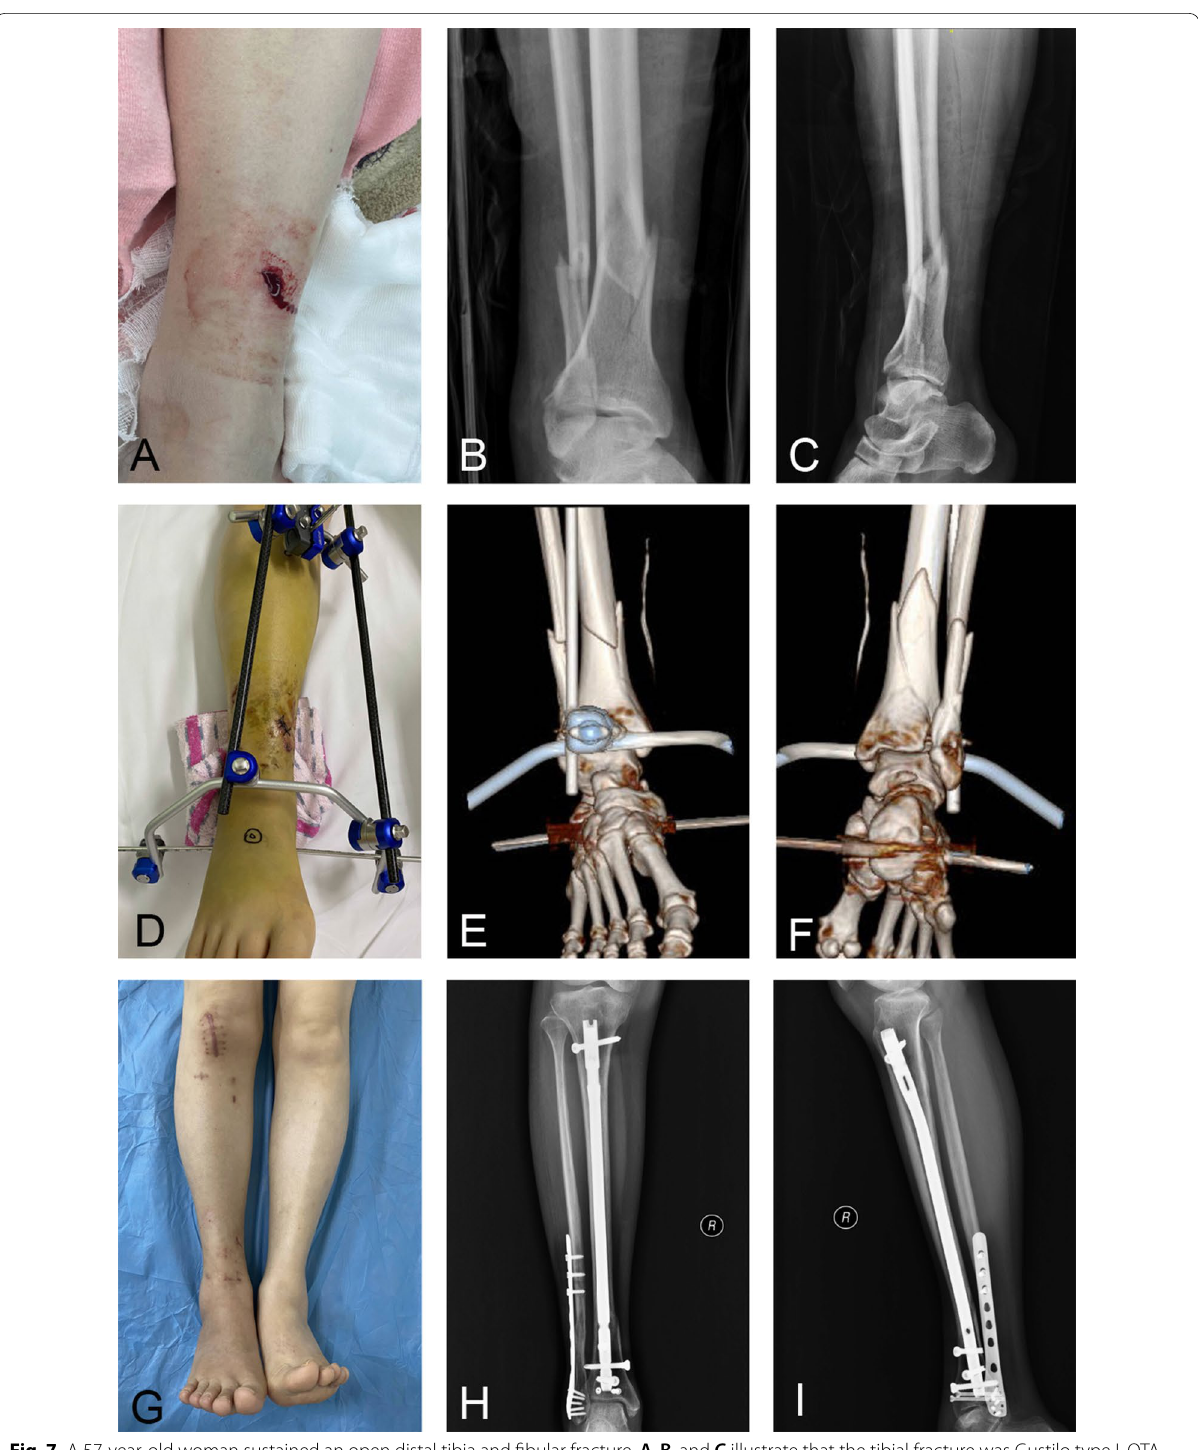
Fig. 7 A 57‑year‑old woman sustained an open distal tibia and fibular fracture. A , B , and C illustrate that the tibial fracture was Gustilo type I, OTA 43‑C1 DTF. D reveals that the patient underwent closed reduction and external fixation. When using three‑dimensional computed tomography, a nondisplaced intraarticular fracture line was obviously visible ( E and F ). G depicts the overall image at the 3‑month follow‑up after SEIP IMN surgery. H and I depict the AP and lateral radiographs of the tibia at the 8‑month postoperative follow‑up. SEIP semi‑extended infrapatellar, IMN intramedullary nail, AP anteroposterior, DTF distal tibial